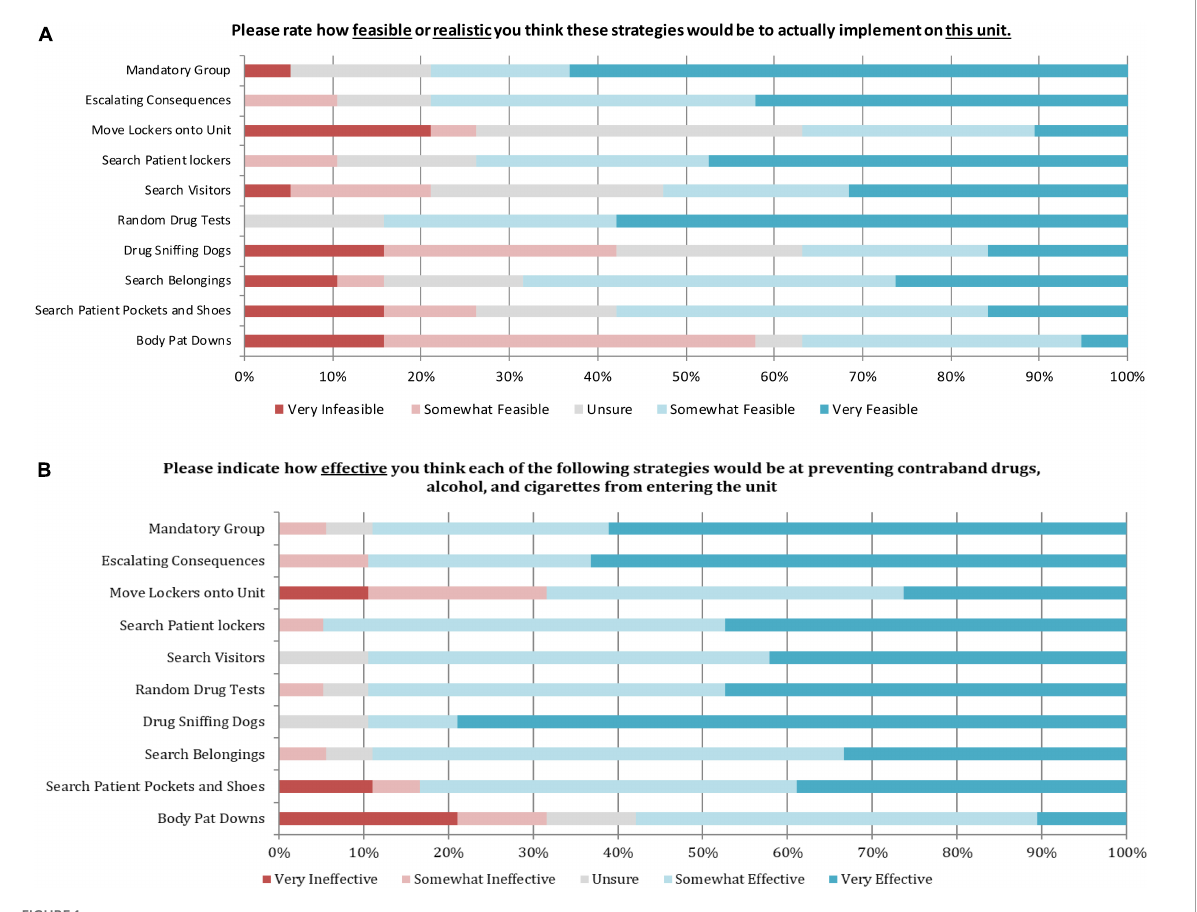
FIGURE1 Results from the frontline staff survey on the perceived feasibility of the 10 suggested strategies ( N = 19). (A) Depicts feasibility. (B) Depicts